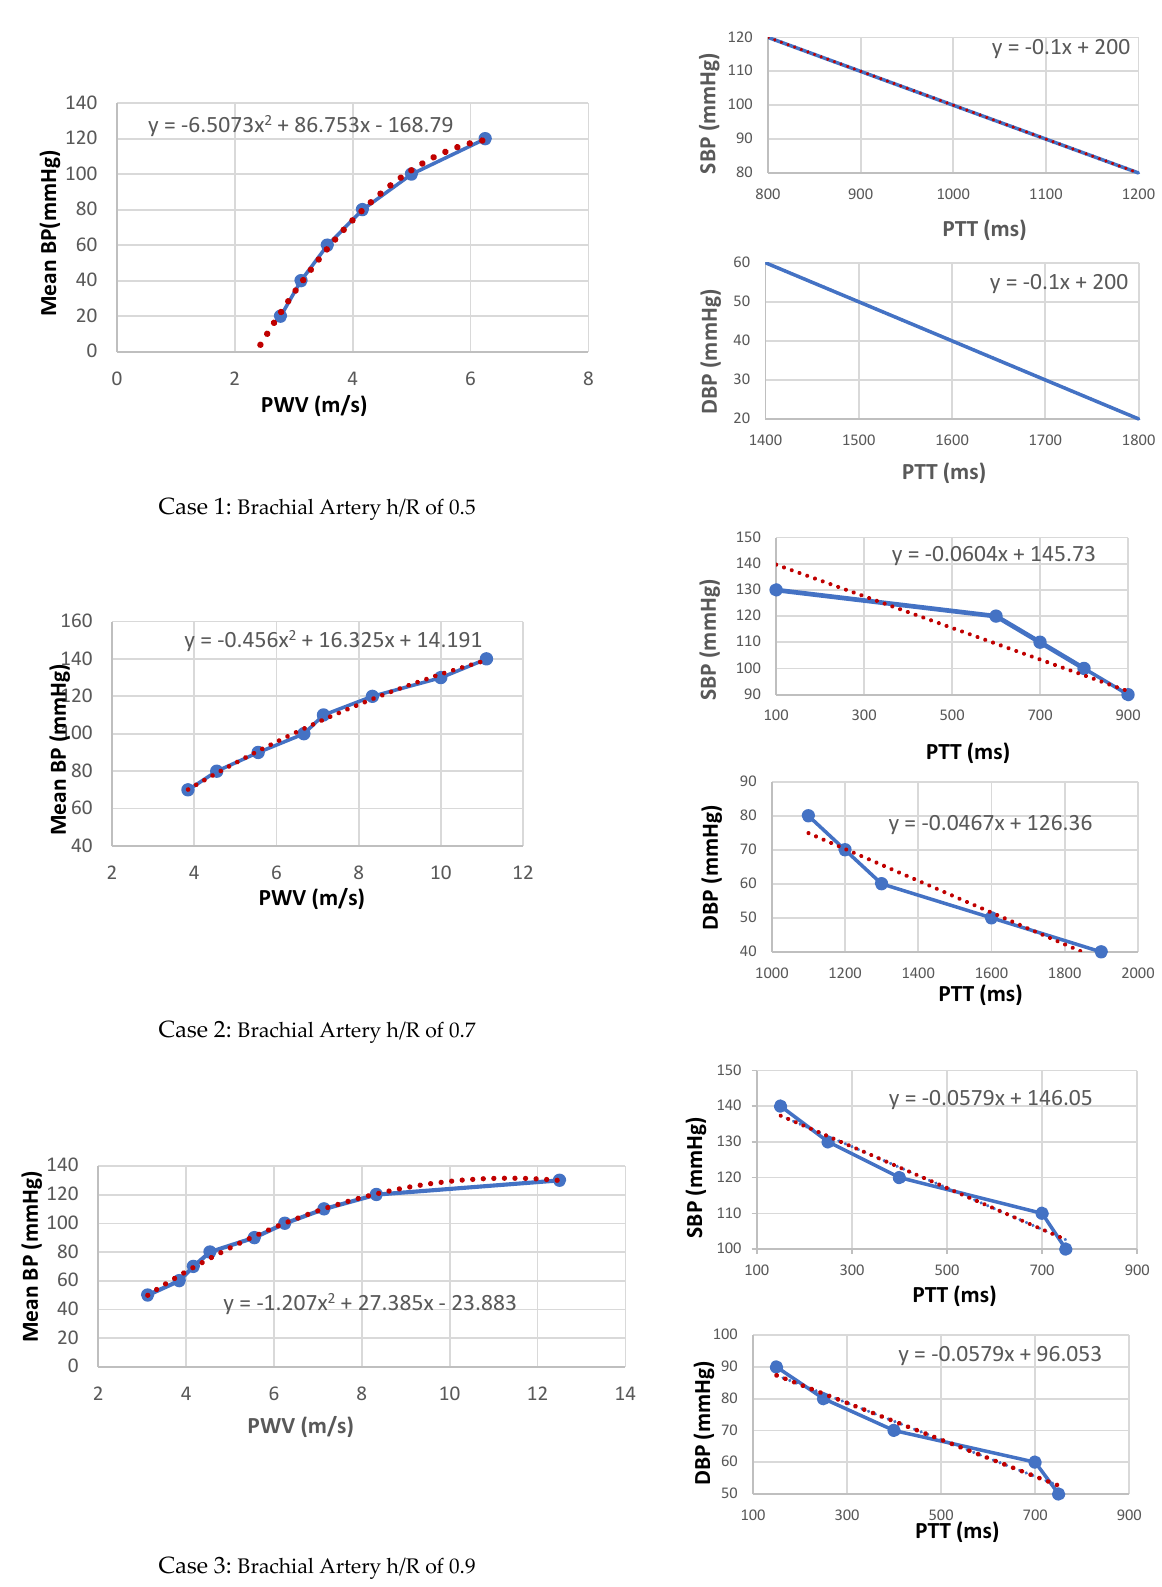
Figure 17. Mean BP versus PWV for the brachial artery of h/R ratios of 0.5, 0.7 and 0.9, with linear regression trend line. In addition, the relationship of PTT to Systolic BP with a straight line representing linear regression and the relationship of PTT to Diastolic BP with a straight line representing linear